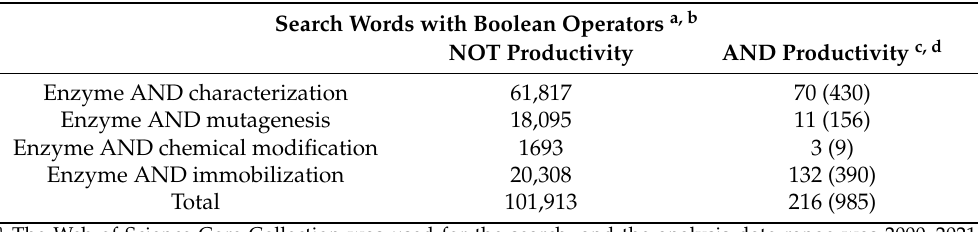
Table 1. Statistics of articles published on enzyme properties, which exclude or include enzymatic